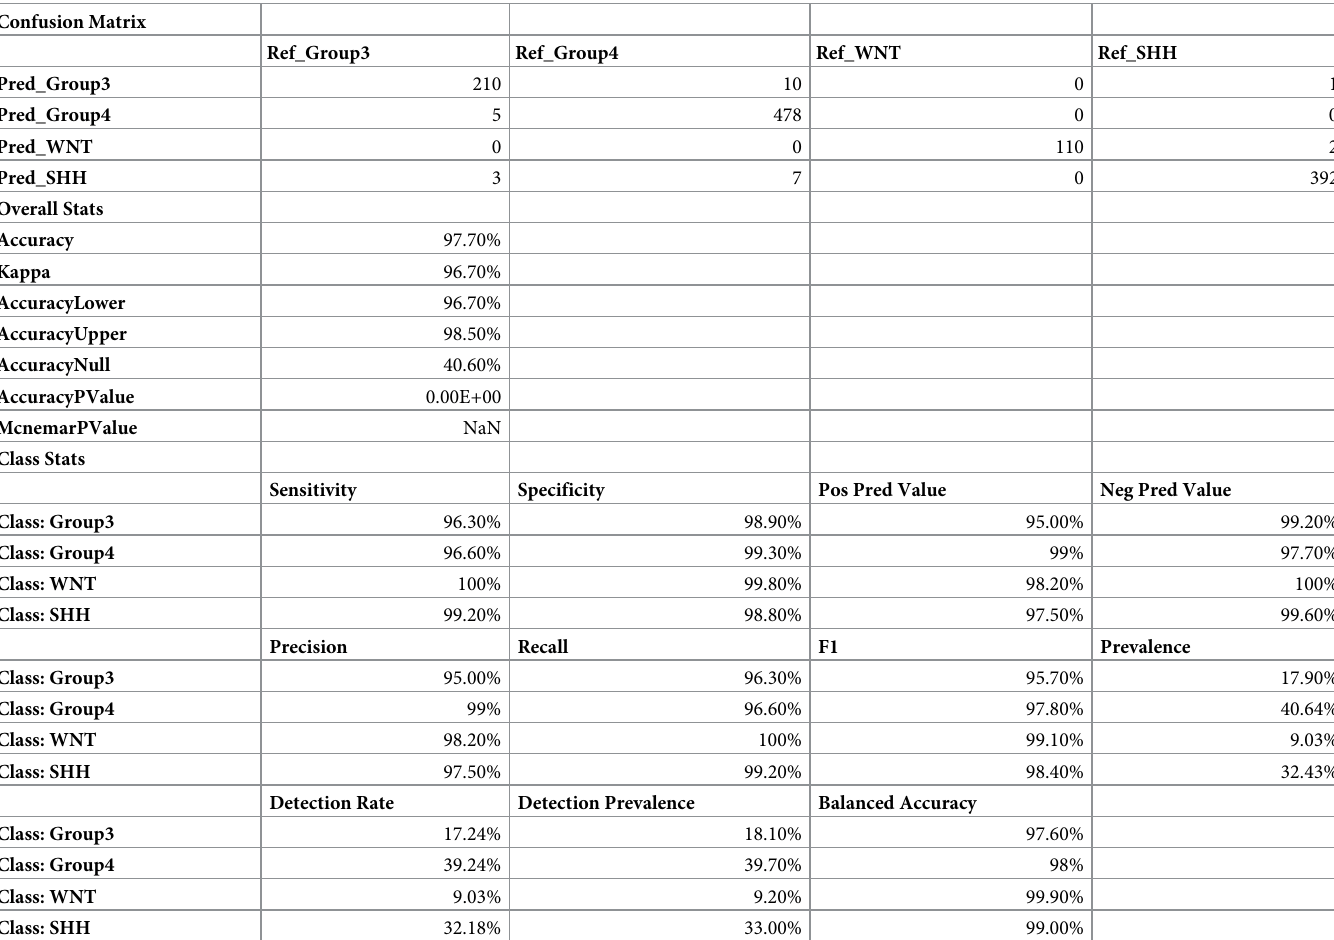
Table 1. Confusion Matrix, Accuracy, and other evaluation metrics obtained after combining 15 test MB datasets followed by applying the classifier on the com- bined dataset (N = 1,286